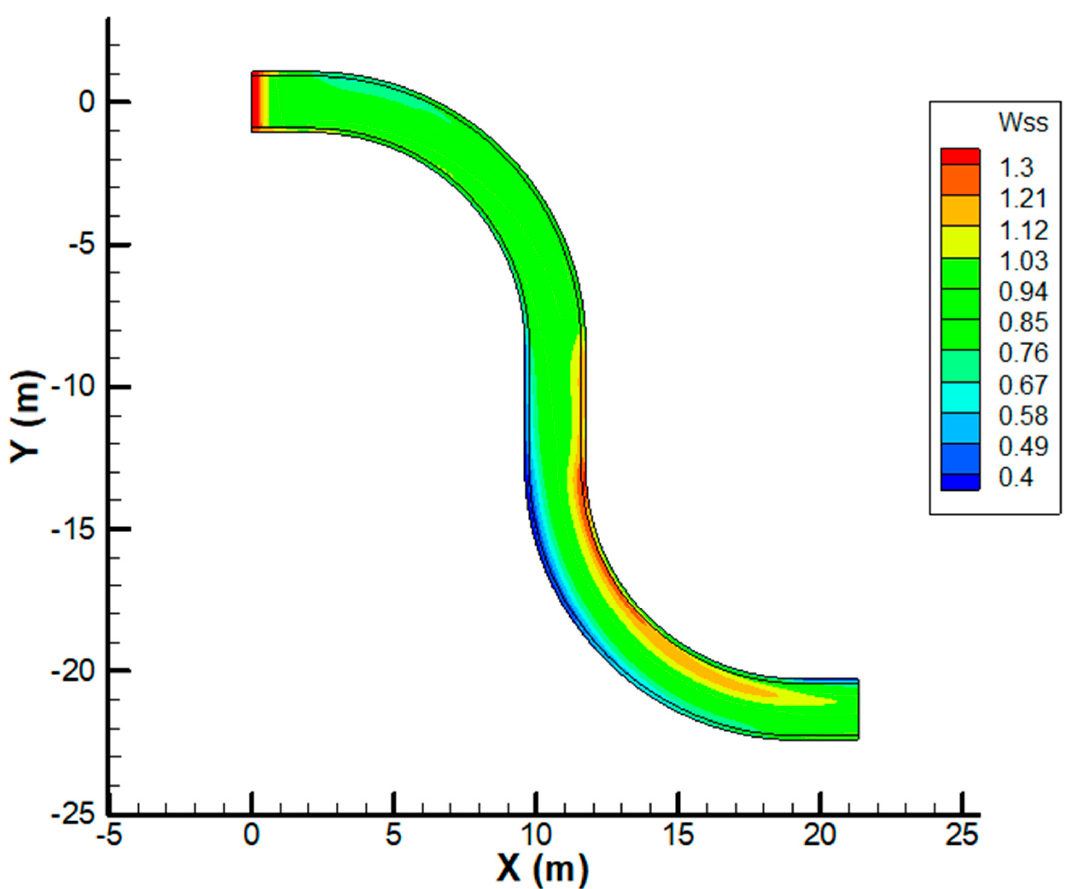
Figure 14. Patterns of dimensionless boundary shear stress simulated using the fine three-dimensional (3D) model